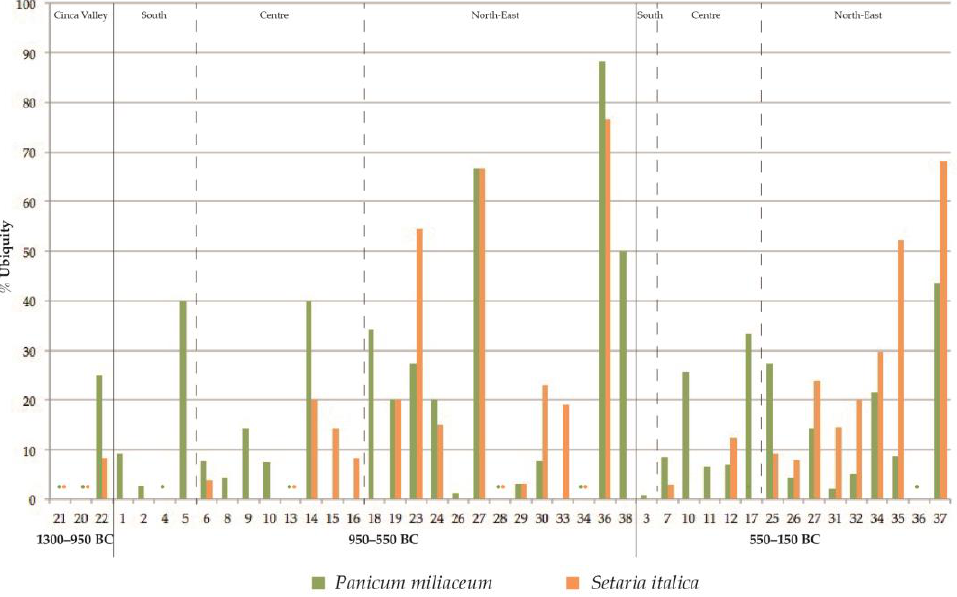
Figure 2. Graph illustrating the percentage of ubiquity (( N samples with taxon/ N total samples) × 100) of broomcorn and foxtail millet from sites yielding more than five samples (those with lesser numbers are represented by a dot). The numbers correspond to the sites from Table 2. On the other hand, as noted in Table 1, most of the sites yielded a limited number of sites while foxtail millet only exceeds this value in 34% of the cases. Certain sites also reveal great concentrations (more than 1,000) of each taxon. However, assemblages of Panicum miliaceum assemblages were only brought to light at Cabezo de la Cruz (8th-7th century BC) in two of the three houses and in smaller numbers in several open spaces. These two concentrations, preserved by charring, correspond to 3,384 remains from dif- ferent groups unearthed in House 1 and a single large assemblage of 62,457 from House 6. The remaining cases correspond to concentrations of Setaria italica . This is the case of the 1,241 finds from stratigraphical unit 92 at Torrelló d'Almassora (7 th -6 th century BC), 3,496 from Puig de Sant Andreu, and above all the lot from Mas Castellar de Pontós [36] which can be broken down into three concentrations. The first (21,537) associated with an oven (FR-19) consists for the most part of foxtail millet (3,162) and a scant number of broomcorn millet (14). The second (16,444) was recovered in a pit (FS-6) related to cereal storage and domestic handling. It basically contained a combination of hulled barley ( Hordeum vulgare ) and foxtail millet. The third (7,572 foxtail millets and 355 broomcorn millets) was collected in a waste heap (Ab-38). The three appear to be the outcome of ran- dom charring. It must also be noted that when taking into account the sites benefitting from archae- obotanical analyses throughout the area, millets were only recovered at 12% from the 26 sites of the Late Bronze Age (1300-950 BC), 61% from the 38 of the First Iron Age (950-550 BC), and 40% of the 52 from the Iberian period (550-150 BC). This confirms, that the First Iron Age is the period when these crops saw their greatest surge and expansion, a notion advanced in other research [39,40]. Certain of the chronological ranges published here for the first time are direct datings carried out on the oldest millet specimens, notably those from Cova de Punta Farisa and Masada de Raton, while others were gleaned from analyses carried out on other types of materials (bone, other seeds) from the same contexts (Table 2). The oldest seeds are foxtail millets from the site of Cova de Punta Farisa with a mean of 1240 cal BC (1380-1125 cal BC). This assemblage is followed in time by the dating of phase 2 of the site of Vincamet